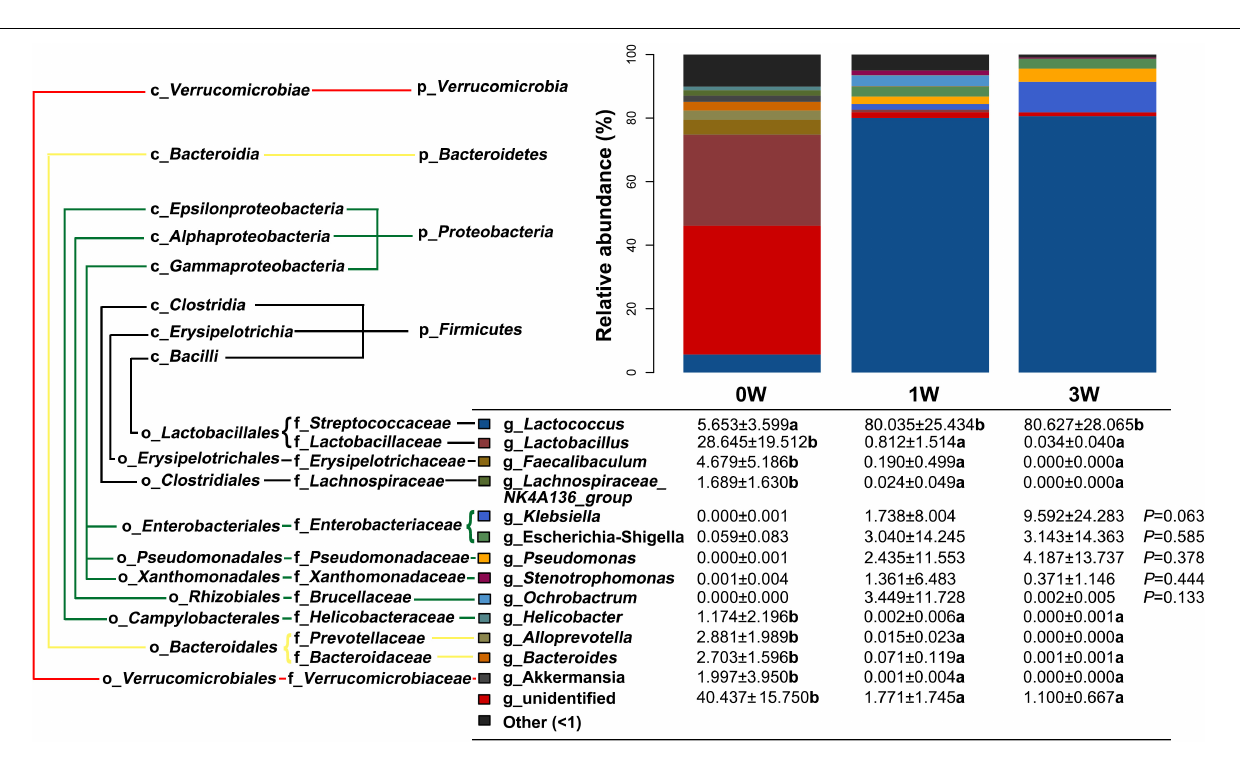
Frontiers in Nutrition |